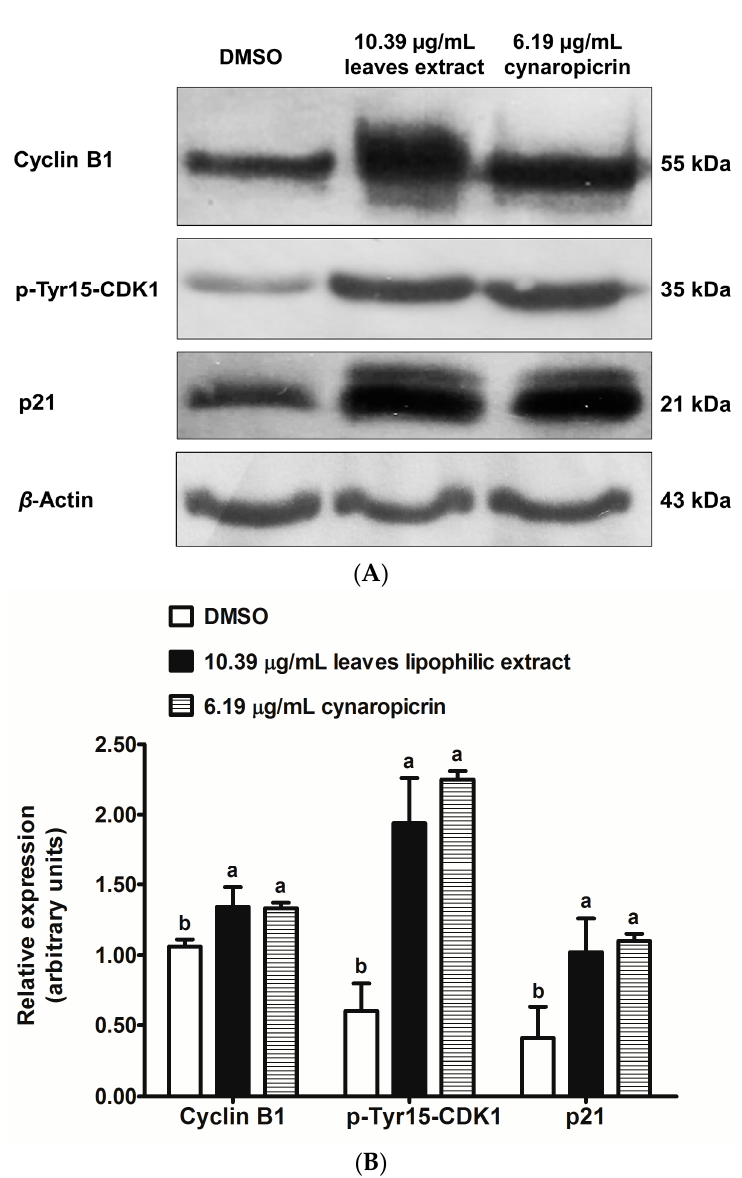
Figure 4. Western blot analysis of cyclin B1, p-Tyr15-CDK1 and p21 in MDA-MB-231 cells, after 48 h treatments with 10.39 µg/mL cultivated cardoon leaves lipophilic extract and 6.19 µg/mL cynaropicrin. DMSO (0.09% ( v / v )) was used as solvent control. ( A ) Representative image of immunoblots; ( B ) Relative expression determined by analysis of band integrated density and normalization to β -actin. Each column and bar respectively represents the mean and the standard deviation of three independent experiments. Columns of each protein with different letters are statistically different ( p < 0.05).